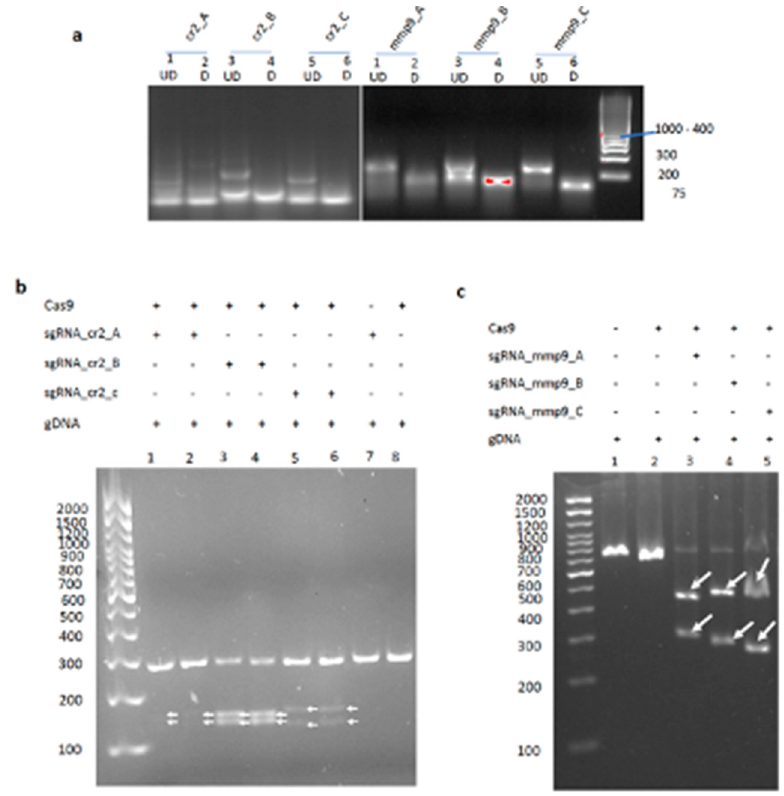
Figure 1. sgRNA analysis and in vitro cleavage assay for cr2 and mmp9 genes. ( a ) sgRNA analysis on 2% agarose gel. UD: undenatured sgRNA, D: denatured sgRNA. Single bands detected for the denatured sgRNAs highlighted the purity of the products, and multiple bands in the undenatured sgRNA resulted from the presence of RNA secondary structures; ( b ) gel shows duplicate lanes for each sample. Lanes 1–6: experimental samples, lane 7: no Cas9 control, lane 8: no sgRNA